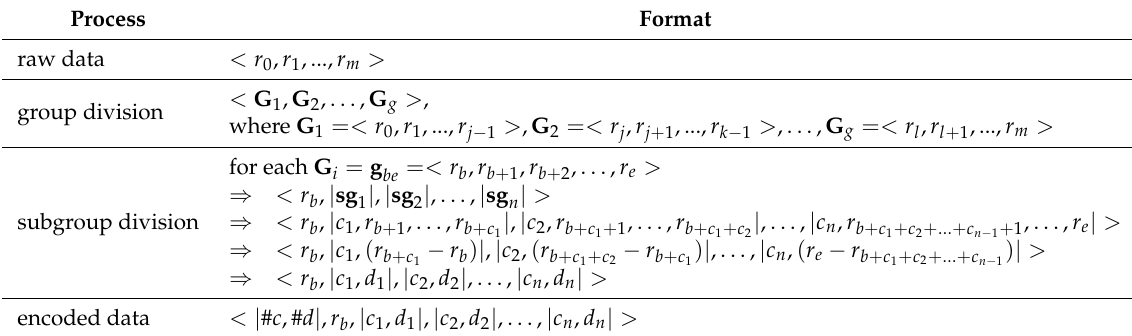
Table 3. Data formats in